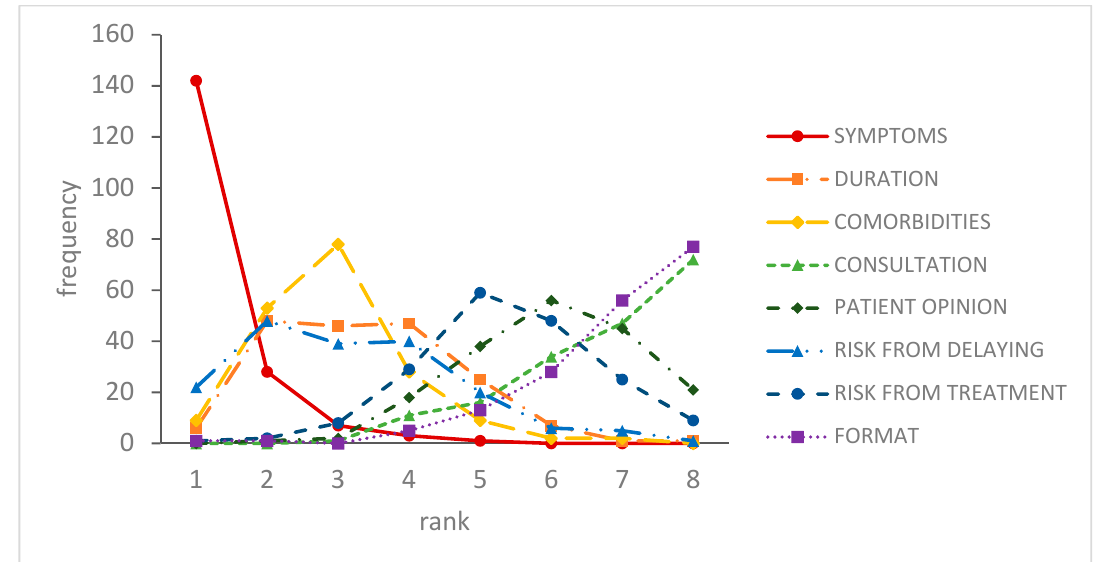
Figure 1. Ranking of attribute importance. Attribute descriptions: DURATION: duration of illness prior to consultation; CONSULTATION: length of consultation; PATIENT OPINION: preferences regarding antibiotics expressed by the patient; RISK FROM DELAYING: risk of harm from not starting antibiotics straight away; RISK FROM TREATMENT: risk of adverse effects from taking antibiotics; FORMAT: how the delayed prescription would be provided. Vertical axis indicates the number of respondents who ranked a given attribute at the rank shown on the horizontal axis (1 = highest rank).